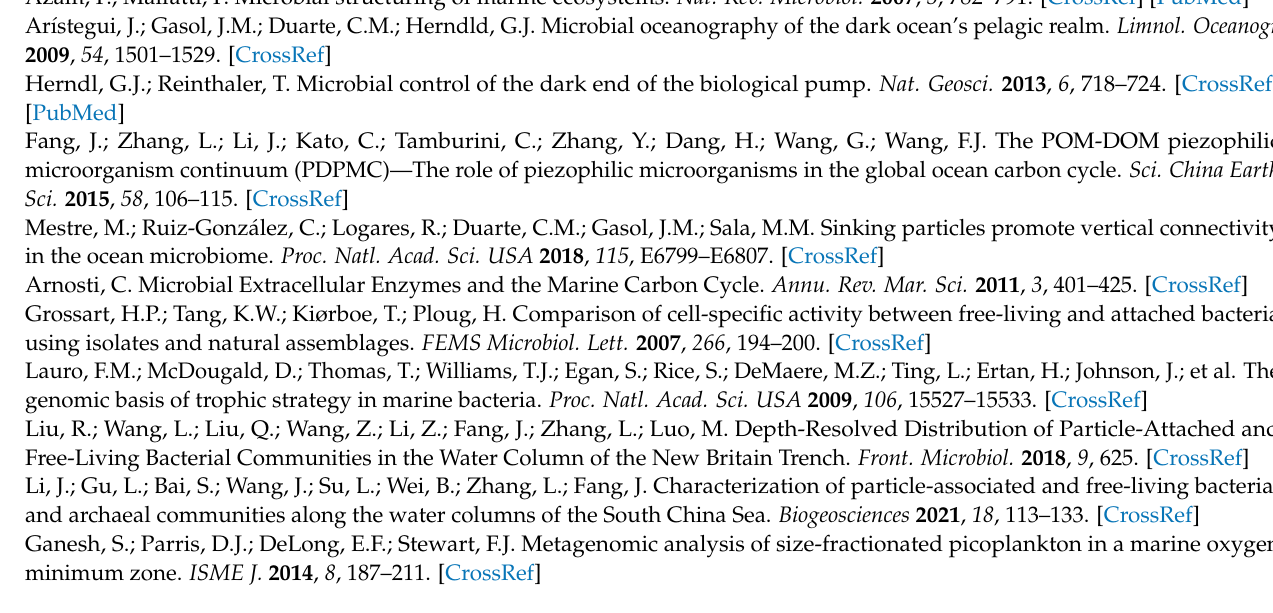
Figure S3: The quantitative distribution of the 16S rRNA gene in the 3rd–14th DNA fractions across different buoyant density gradients of the PAM and FLM assemblages incubated with 13 C- or 12 C- POC at 0.1, 20, and 40 MPa. (a) 0.1 MPa-PAM; (b) 0.1 MPa-FLM; (c) 20 MPa-PAM; (d) 20 MPa-FLM; (e) 40 MPa-PAM; (f) 40 MPa-FLM, Figure S4: Venn diagrams showing the number and percentage of shared and unique OTUs in the ISW, total, and active PAM and FLM assemblages incubated at 0.1, 20, and 40 MPa. ISW represents the East China Sea in situ surface water. Table S1: The physical and chemical parameters of the surface water collected from the East China Sea.; Table S2: The 16S rRNA gene sequencing data of PAM and FLM at 0.1, 20, and 40 MPa, respectively; Table S3: Diversity indices of the total and active PA and FL microbial 16S rRNA gene at 0.1, 20, and 40 MPa, respectively; Table S4: The P values and significance of alpha diversity indices and OTUs number between different comparisons in the total and active microbial communities; Table S5: Analysis of similarity (ANOSIM) between the PAM and FLM assemblages before and after incubation at 0.1, 20, and 40 MPa, respectively; Table S6: phylogenetic classification and average relative abundance of module hubs and connectors for the PAM and FLM communities at 0.1, 20, and 40 MPa. File S1.